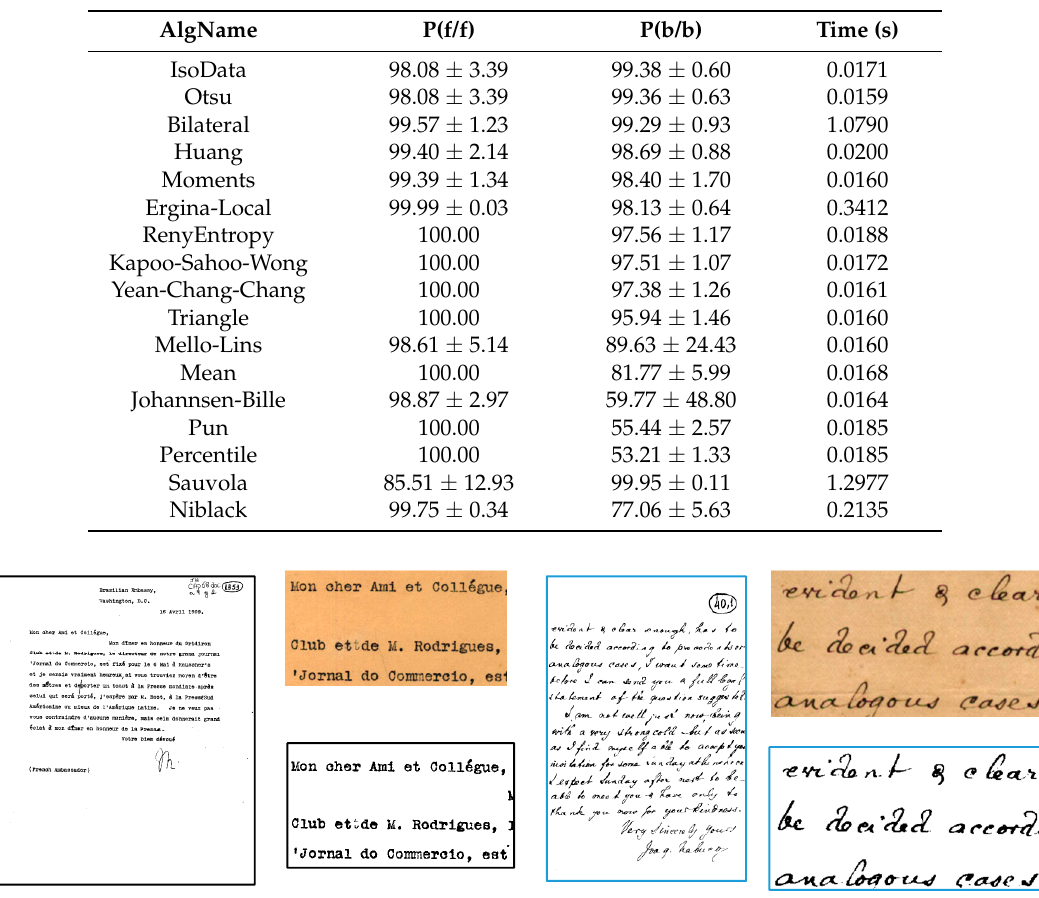
Table 1. Binarization results for images from Nabuco bequest.